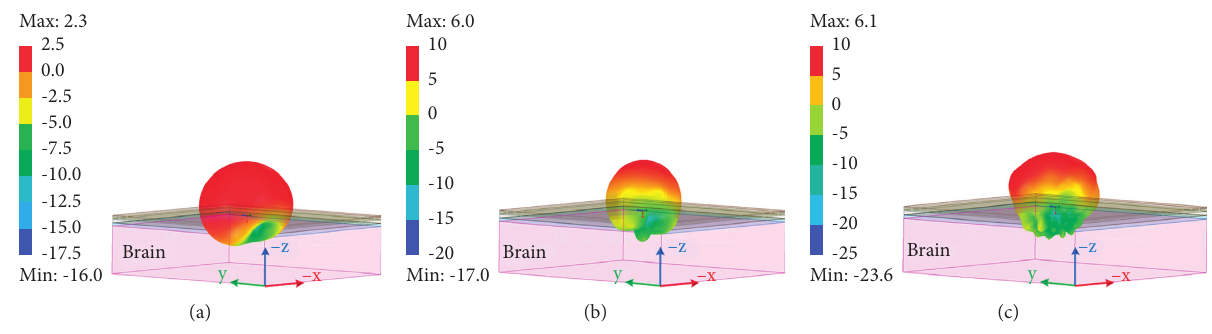
Figure 12: 3D simulated antenna directivity: (a) 402MHz, (b) 902MHz, and (c)